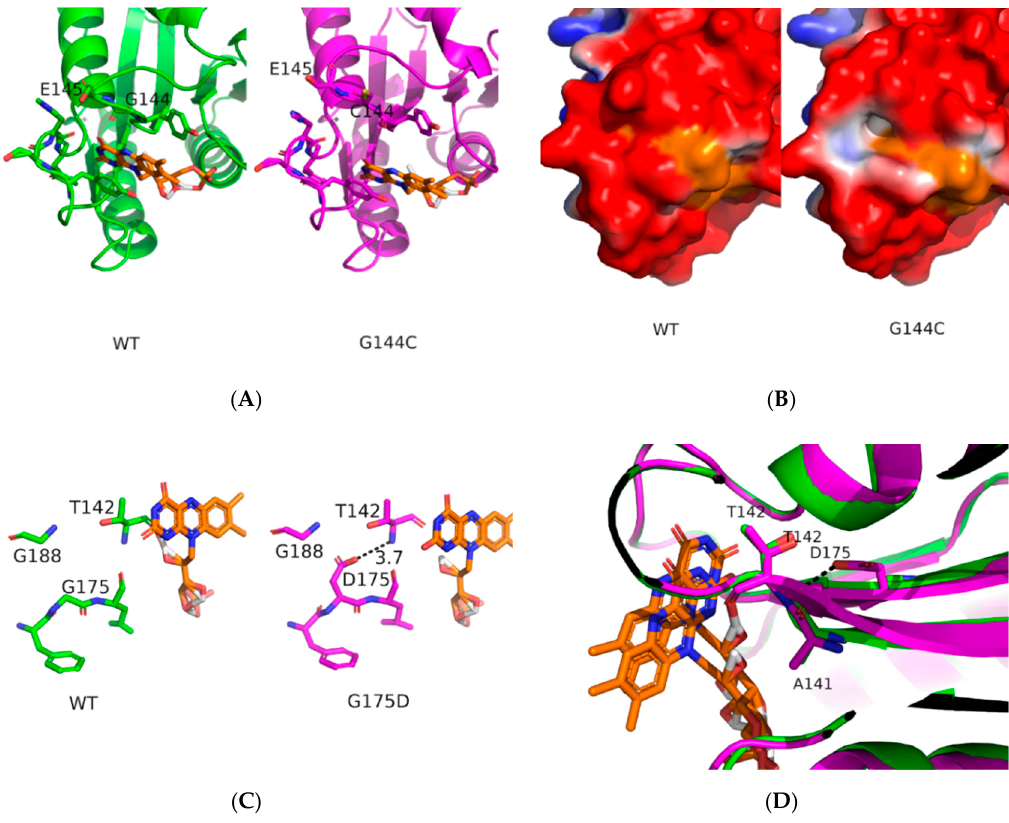
Figure 5. Effects of the G144C and G175D mutations. Panel A presents the wild ‐ type (green, simulation 1) and G144C (magenta, simulation 1) average structures. Panel B presents a mapping of the electrostatic potential onto the solvent excluded surface of wild ‐ type (left) or G144C mutant (right), the orange color corresponds to the surface of the flavin mononucleotide (FMN) residue. Panel C , D presents detailed view of the wild ‐ type (green, simulation 1) and G175D (magenta, simulation 1) average structures.